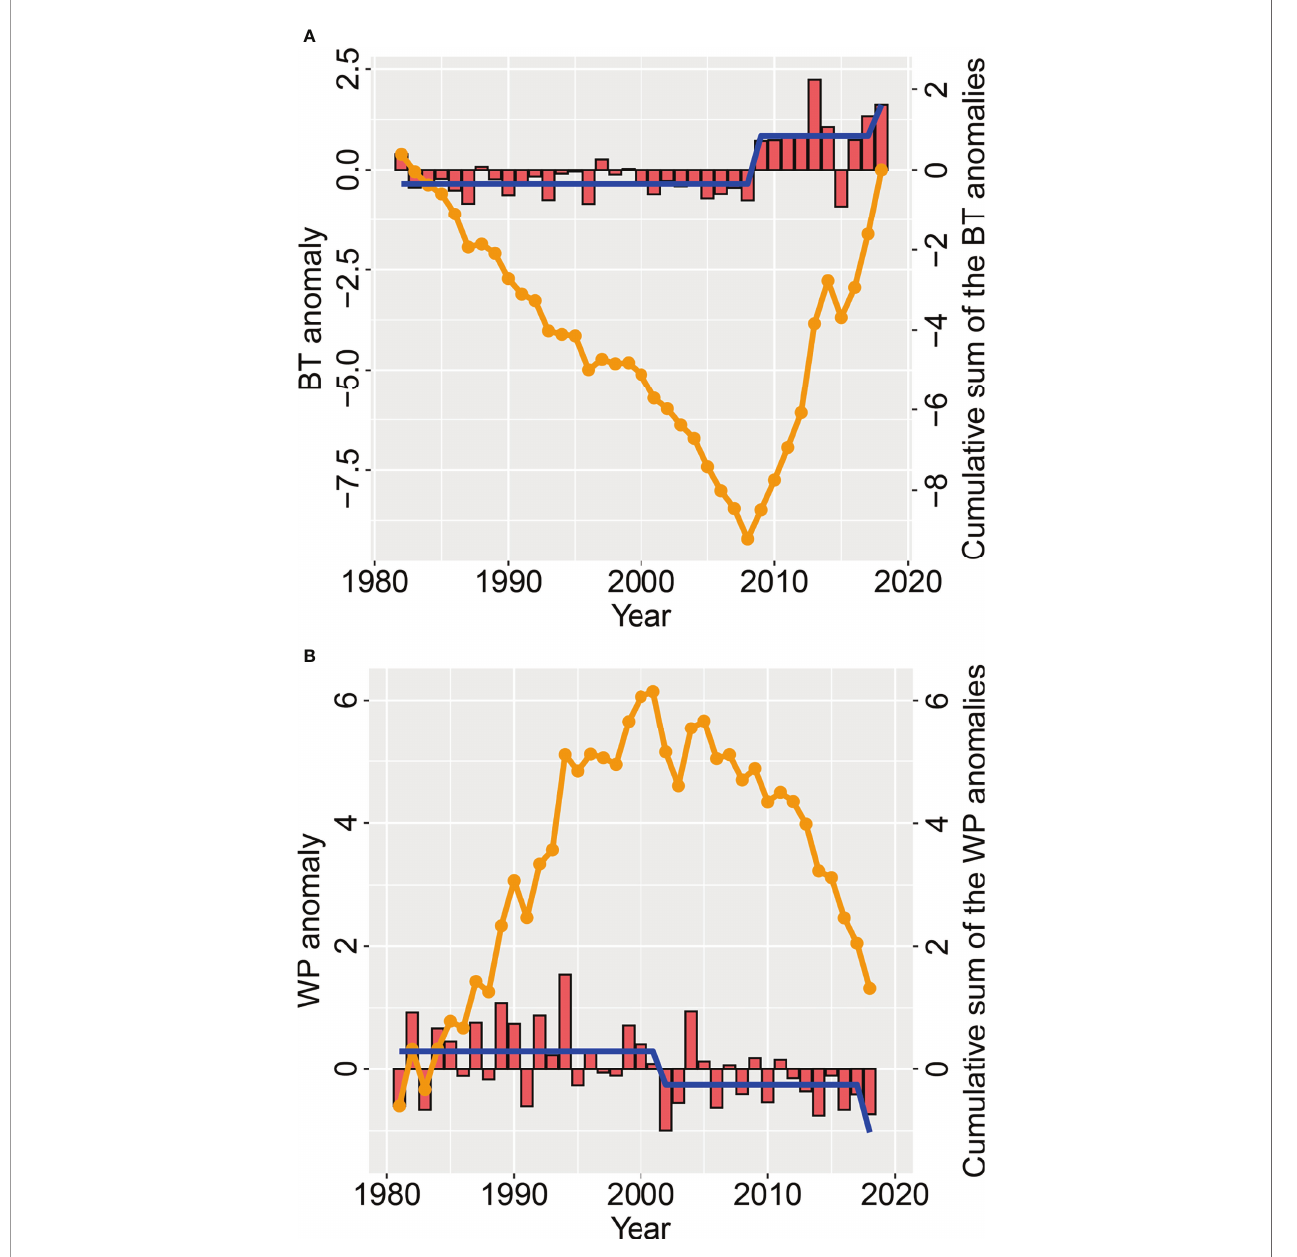
FIGURE 7 | Changes in (A) August bottom temperature (red bars) anomalies (BTA) and (B) summer West Paci fi c index (WPI) anomalies (red bars), as well as the cumulative sum of the BT and WPI anomalies (orange line), in the Bohai Sea over the period 1981 − 2018. The regime shift (blue line) in the WPI and BT is also